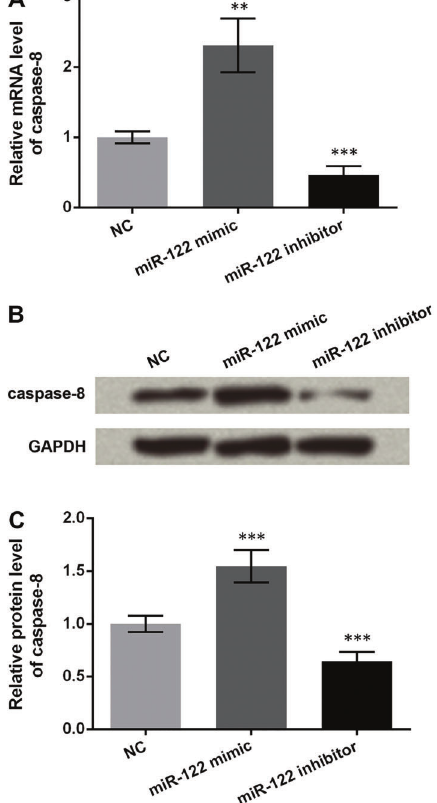
Figure 4. Expression of caspase-8 in transfected mouse cardiomyocytes. Mouse cardiomyocytes were transfected with miR-122 mimic, miR-122 inhibitor or the negative control (NC). qRT-PCR and western blot were performed at 48-h post- transfection to detect the mRNA and protein levels of caspase-8, respectively. A , mRNA level of caspase-8 detected by qRT-PCR. B , Western blot results showing the protein bands of caspase-8 and the internal reference GAPDH. C , Quanti fi cation of caspase-8 protein levels based on western blot results. Data are reported as means ± SD. **P o 0.01; ***P o 0.001 compared to NC group ( t